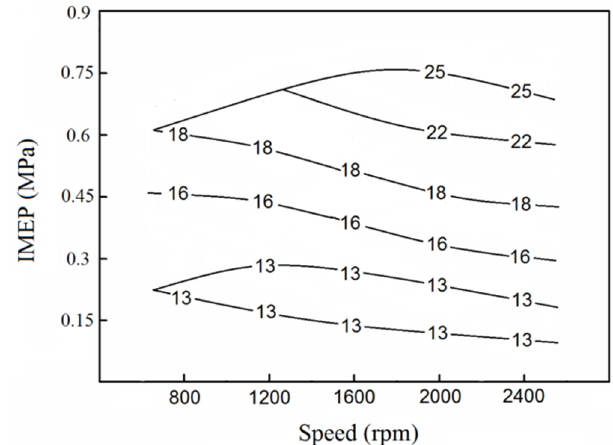
Figure 12. Exhaust gas exergy